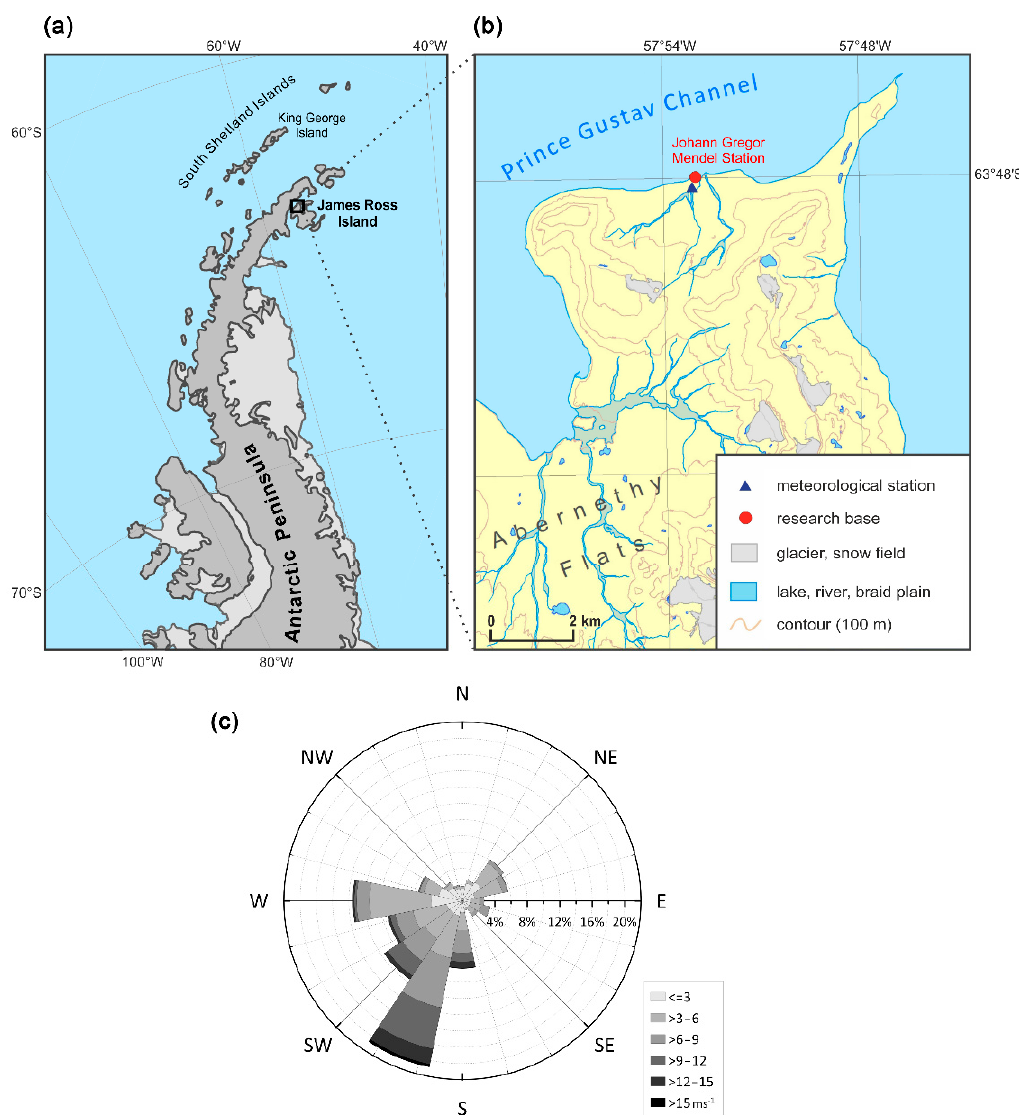
Figure 1. Antarctic Peninsula (AP) region ( a ), measuring site on Ulu Peninsula, James Ross Island ( b ) and wind rose representing wind frequencies with respect to their wind speed from study site for period from 23 January to 21 March, 2018 ( c ). Table 1. Overview of meteorological parameters (“Parameter“) measured on James Ross Island during 23 January–20 March, 2018. In the “Height/Depth“ column, positive numbers refer to height above the ground, while negative numbers refer to depth.